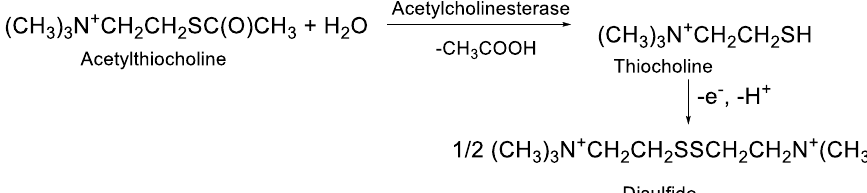
Figure 1. Application of ATCh for the amperometric determination of AChE activity.